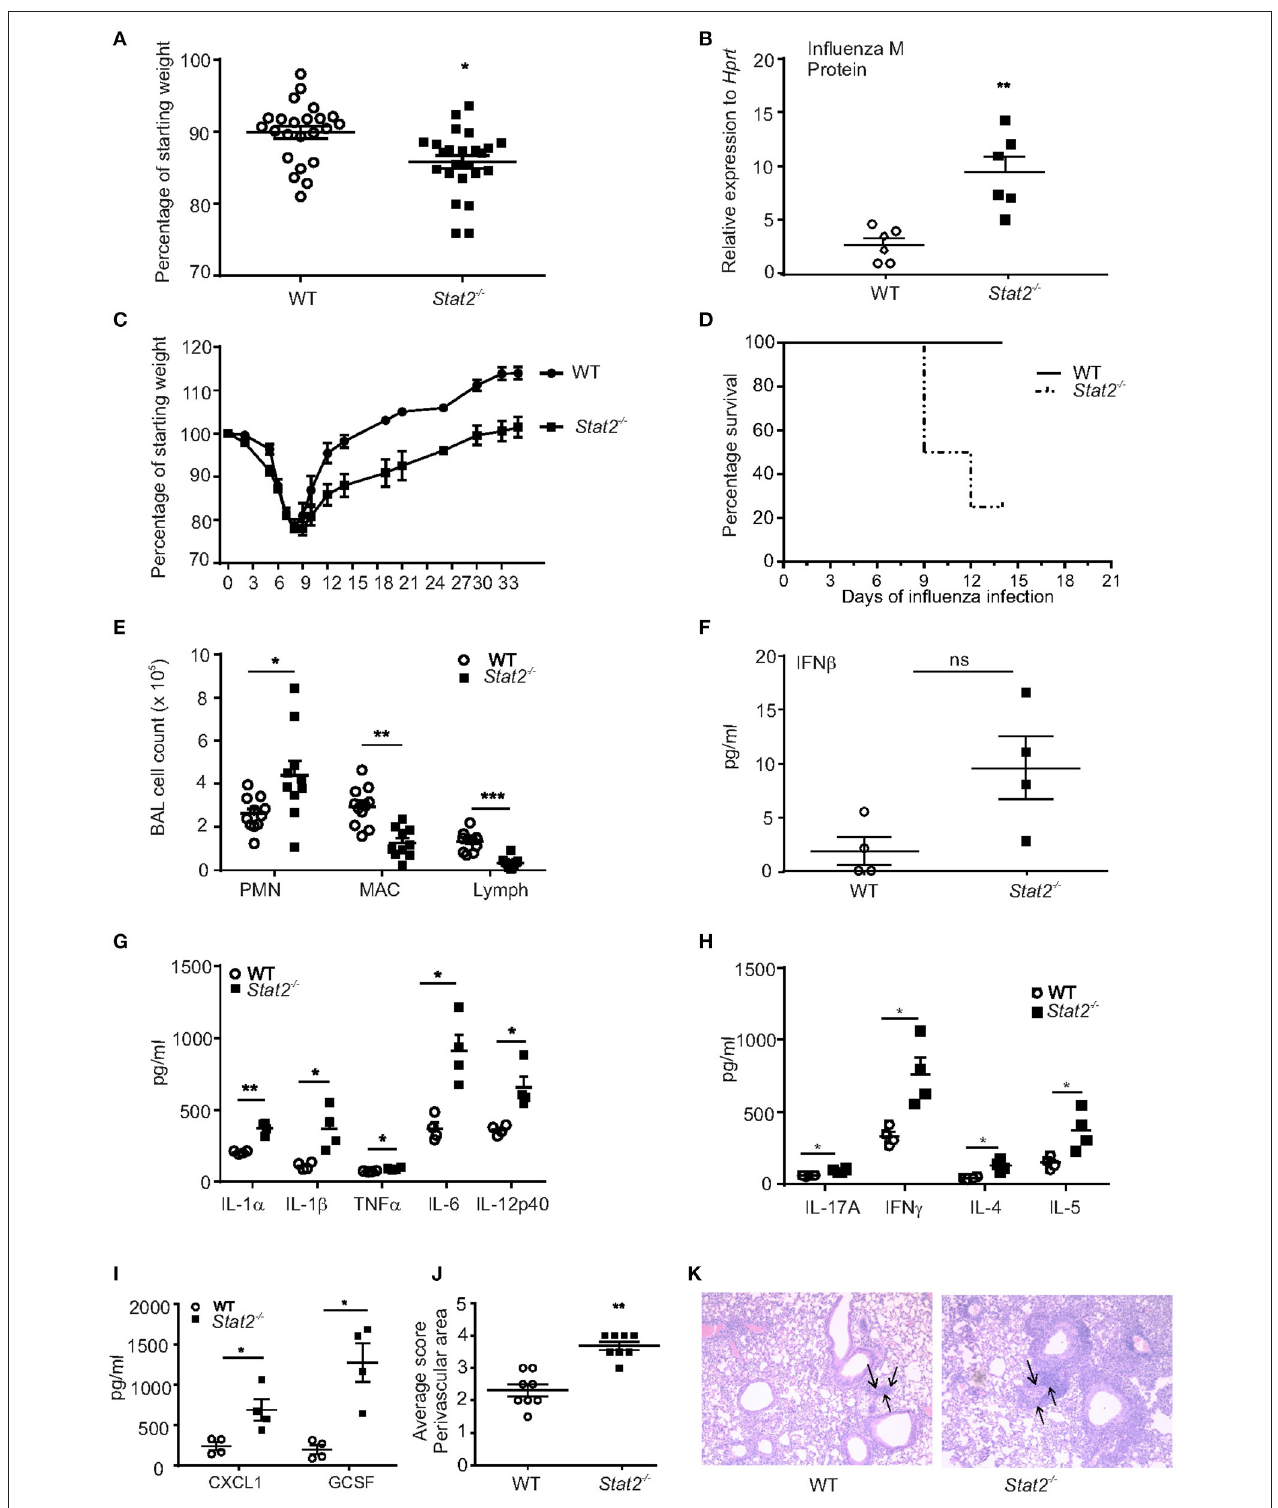
FIGURE 1 | Stat2 − / − mice have increased susceptibility to influenza infection. (A) WT, Stat2 − / − male 6–8 weeks mice were infected with 100 PFU of influenza, percentage weight loss on day 6 of influenza infection, N = 22–24 per group. (B) Viral burden was measured by influenza M protein expression 6 days following influenza infection in whole lung, N = 6 per group. (C) Weight loss during 35 days following influenza infection, N = 8 per group. (D) Percentage survival following